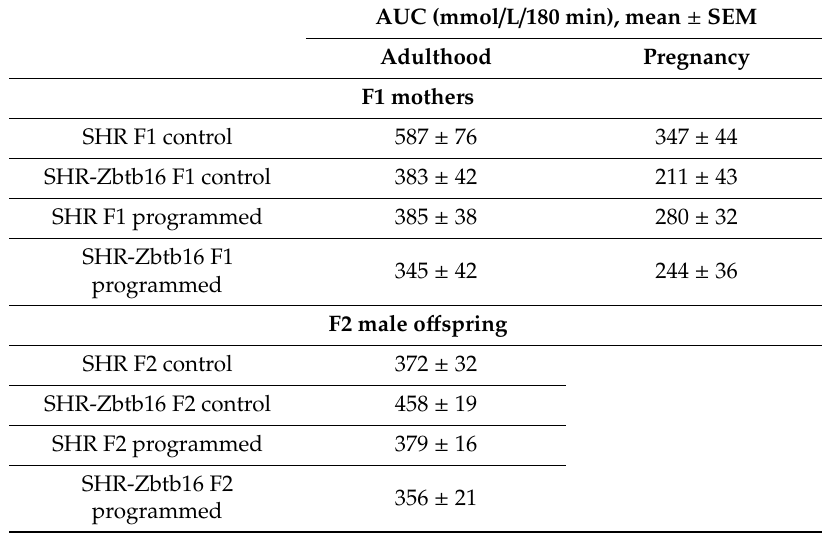
Table 1. Areas under glycaemic curves (AUC) values calculated from course of oral glucose tolerance tests in SHR and SHR-Zbtb16 mothers and their male o ff spring according to Heikkinen et al.